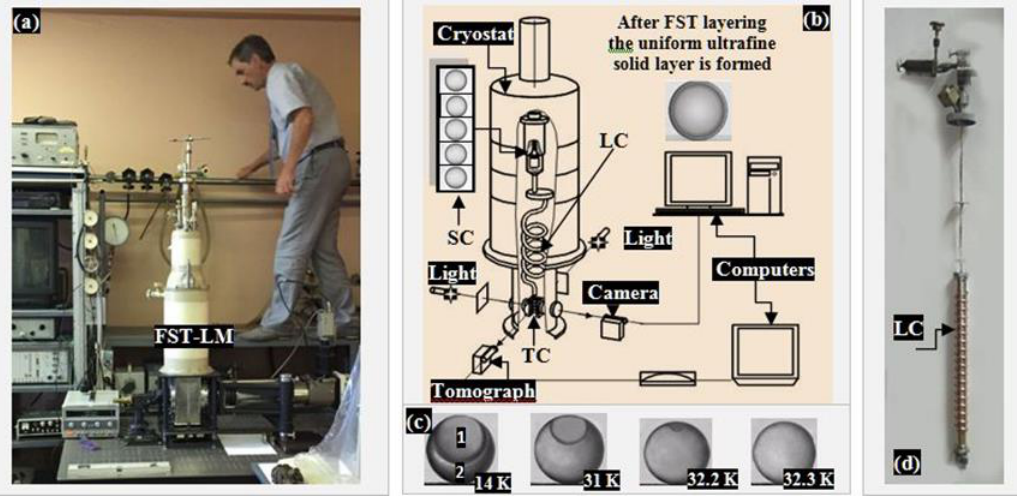
Figure 1. Free-standing target (FST)-layering setup. In ( a ): general view; in ( b ): FST-layering module (LM)—target transport is injection between the basic units: shell container (SC)—layering channel (LC)—test chamber (TC)); in ( c ): (vapor (1) − liquid (2)) interface behavior in 1-mm CH -shell (P = 765 atm of H2 at 300 K); in ( d ): LC as a part of the insert into the cryostat.